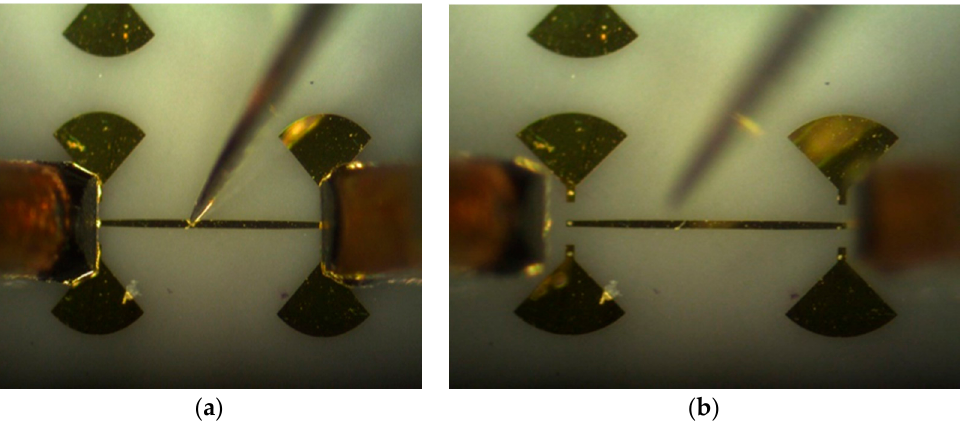
Figure 26. Coplanar and DC probe landings on calibration kit line: ( a ) down; ( b ) up after measurement.